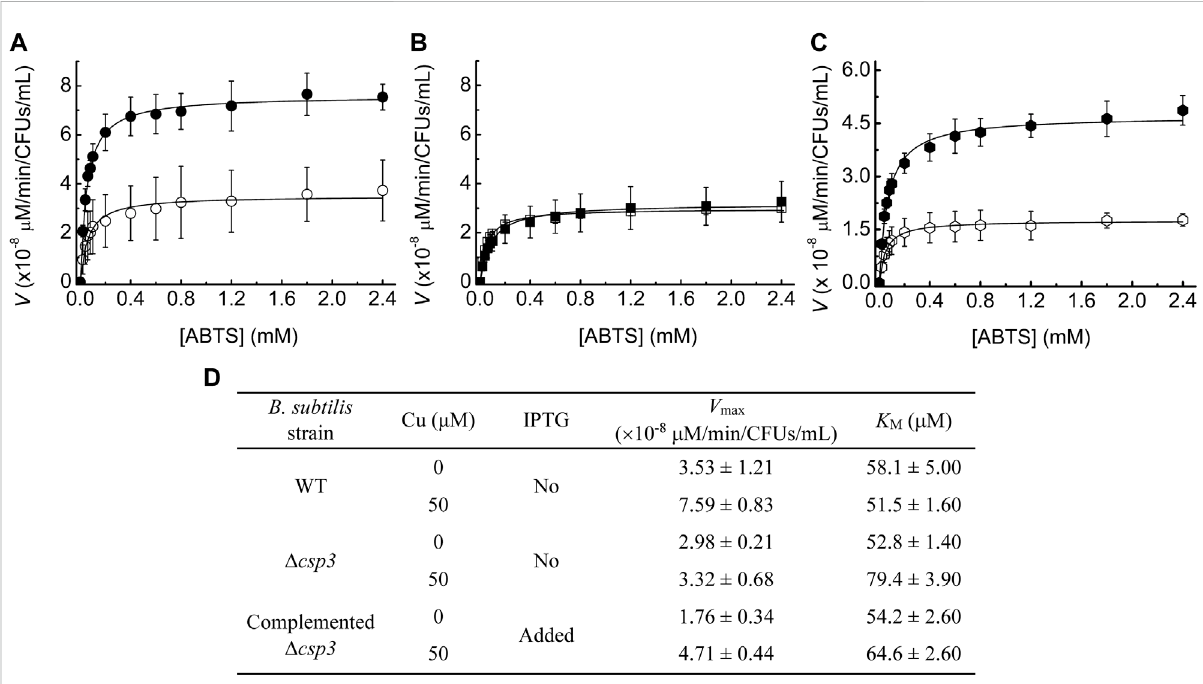
FIGURE 2 The in fl uence ofCulevels and Bs Csp3 on Bs CotA activity in B.subtilis spores. Michaelis-Mentenplots of Bs CotA activity forheatedpuri fi edspores from WT (A) , Δ csp3 (B) , and the complemented Δ csp3 (C) strains. Spores (A,B) were produced in DSM plus no (open symbols) and 50 μ M (black Δ csp3 strain (C) sporulation was carried out in the presence of 1 mM IPTG with either fi lled symbols) added Cu(NO 3 ) 2 . For the complemented no (open symbols) or 50 μ M (black fi lled symbols) added Cu(NO 3 ) 2 . Plots from which the initial rates for WT and Δ csp3 B. subtilis spores were obtained are shown in Supplementary Figure S3. Kinetics measurements were made in 100 mM citrate-phosphate buffer pH 4.0 at 37 ° C using three different sets of spores (averages and standard deviations are shown). (D) The V max and K M values obtained from the fi ts of the data in (A – C) to the Michaelis-Menten equation. The K M values for the oxidation of ABTS by Bs CotA in spores are all in the range of those reported for puri fi ed enzyme (Martins et al., 2002; Durão et al., 2008; Fernandes et al.,